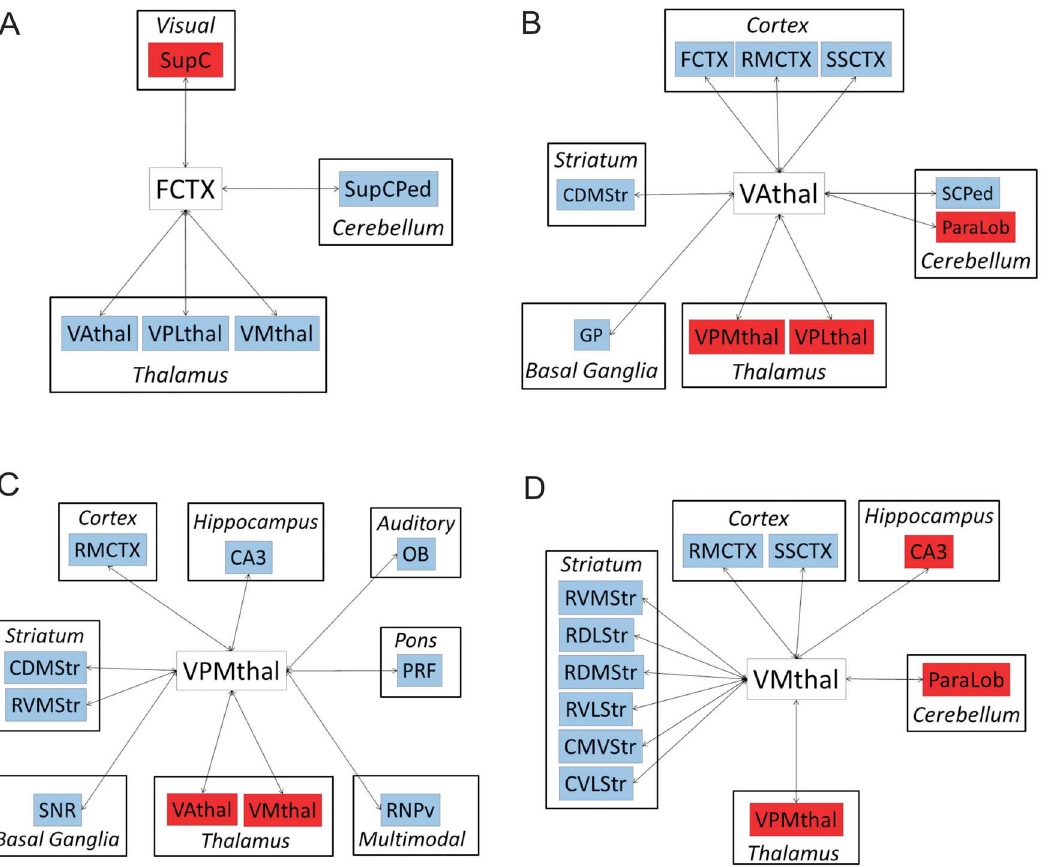
Figure 5. Thalamocortical, thalamostriatal and intrathalamic functional connectivity in Myk / + mice. Summary diagrams showing altered functional connectivity of (A) frontal cortex (FCTX), (B) ventral anterior thalamic nucleus (VAthal), (C) ventromedial thalamic nucleus (VMthal), and (D) ventral posteromedial nucleus (VPMthal) in Myk / + mice. Only regions where the 95% CI of the VIP exceeded 0.80, in either Myk / + or + / + mice, were considered to be functionally connected to the defined ‘‘seed’’ region of interest. The I810N Myshkin mutation-induced alterations in functional connectivity were analysed by permutation test (1000 random permutations of the real data) with significance set at P , 0.05. Red denotes a significant increase, whereas blue denotes a significant decrease, in regional functional connectivity in Myk / + mice relative to + / + .